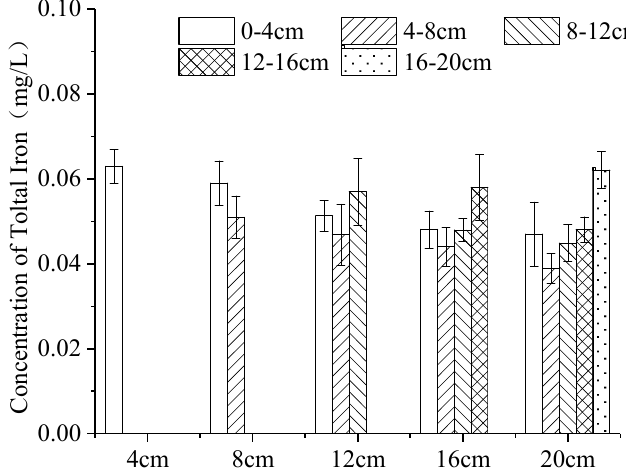
Figure 5. Distribution of iron at varying icing thicknesses in the ice body. (Error bar: Mean ± S.D., K: the ratio of the average concentration of iron in the ice to that in the under-ice water).